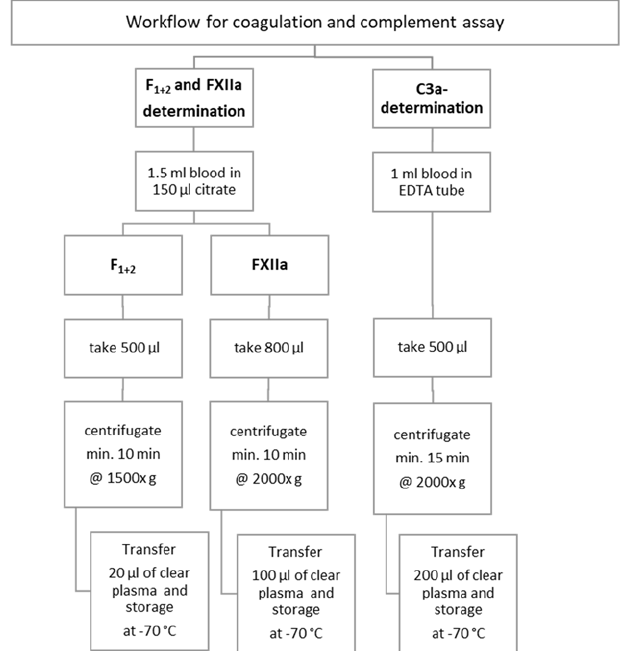
Figure 1. Workflow of preparing blood samples for ELISA assays and testing markers of activated coagulation and complement system.